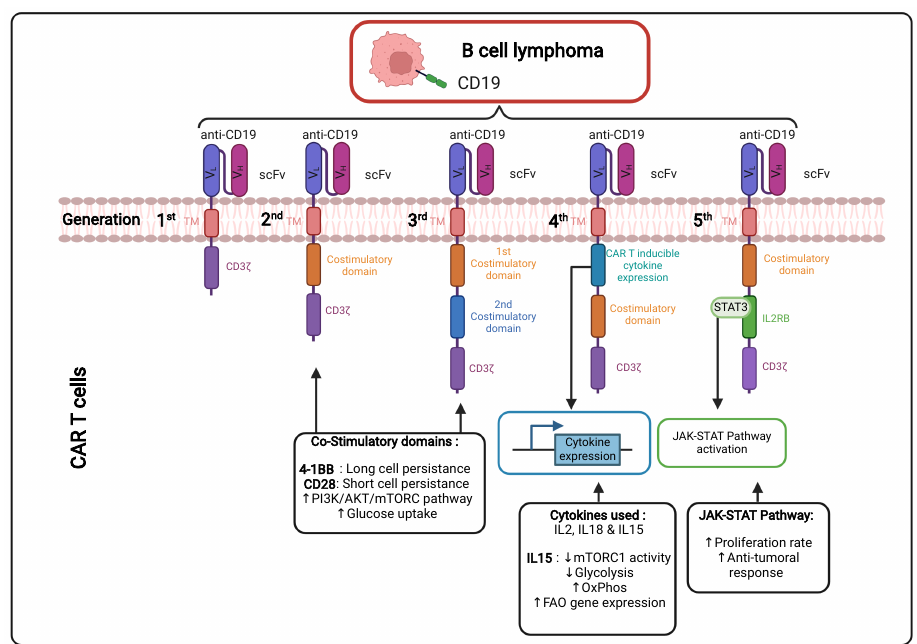
Figure 2. Different generations of CAR T cells and their signaling pathways. TM: Transmembrane; scFv: Single-chain variable Fragment; V L : Variable Light chain; V H : Variable Heavy chain; IL2RB: in- terleukin 2 Receptor B; mTORC: mammalian target of rapamycin complex; FAO: Fatty Acid Oxidation; JAK-STAT: Janus Kinase-Signal Transducers and Activators of Transcription; PI3K: Phosphoinositide 3-kinase; Akt: Protein kinase; CART: Chimeric Antigen Receptor T cell. Figure